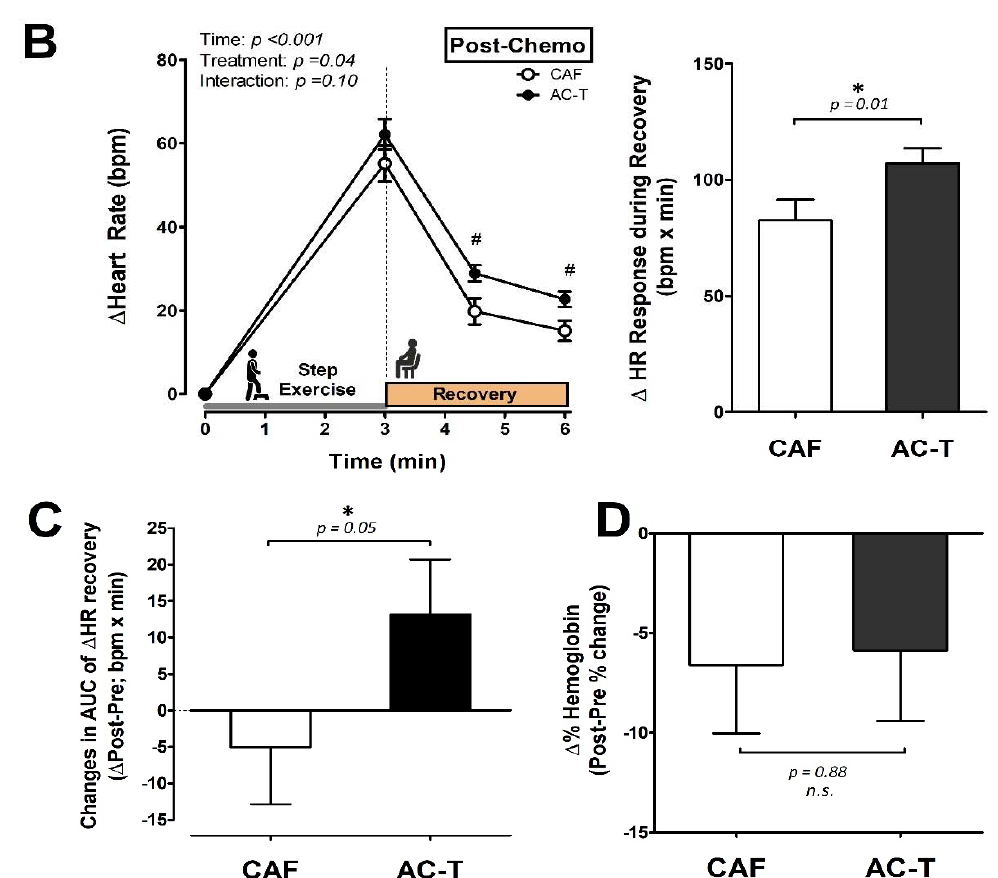
Figure 3. The heart rate responses to a step exercise tolerance test. ( A ) The heart rate responses to the exercise tolerance test and the recovery heart rate AUC (Recovery HR AUC) at the baseline before chemotherapy administration. ( B ) The heart rate responses to the exercise tolerance test and the recovery heart rate AUC (Recovery HR AUC) after the completion of chemotherapy administration. ( C ) The changes in HR recovery AUC between Pre- and Post-chemotherapy. ( D ) The percentage change in the hemoglobin levels between Pre- and Post-chemotherapy. CAF, cyclophosphamide-anthracycline-5-FU; AC-T, cyclophosphamide-anthracycline + taxane. # denotes the difference between CAF and AC-T using post-hoc test ( p < 0.05). * denotes the significant difference between Pre- and Post-chemo ( p < 0.05). Data presented as mean ± S.E.M.